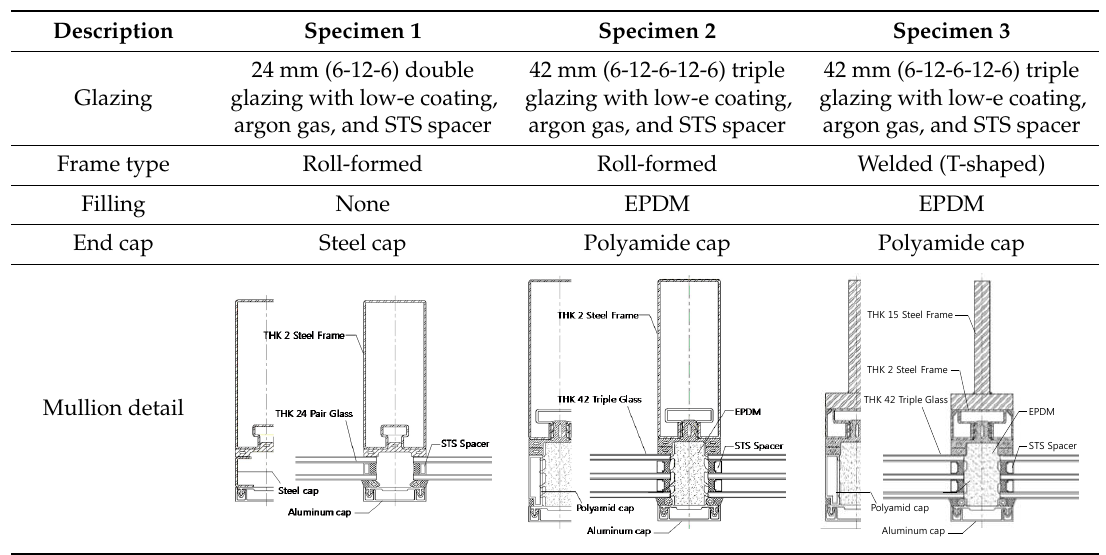
Table 2. Specification of the test specimens for validation.